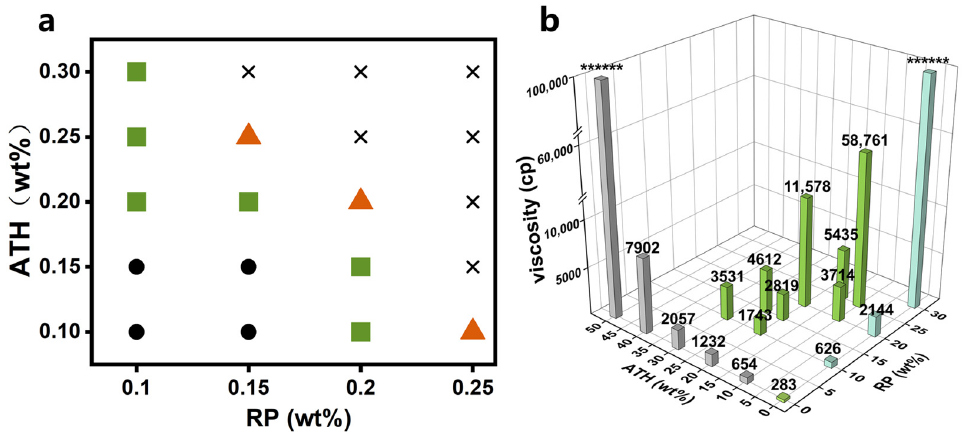
Figure 4. ( a ) The green square represents the range of emulsions with good film-forming properties; the orange triangle represents the mixed emulsions with cracks on the film surface; the cross represents the emulsions that are speculated to be unable of forming a good film; the circle represents the emulsions that are speculated to be able to form a good film; ( b ) Viscosities of the emulsions with different flame retardant concentrations. Gray represents the emulsion viscosity after mixing ATH alone into 906 emulsion, green represents the emulsion viscosity after mixing RP and ATH into 906 emulsion, blue represents the emulsion viscosity after mixing RP alone into 906 emulsion.